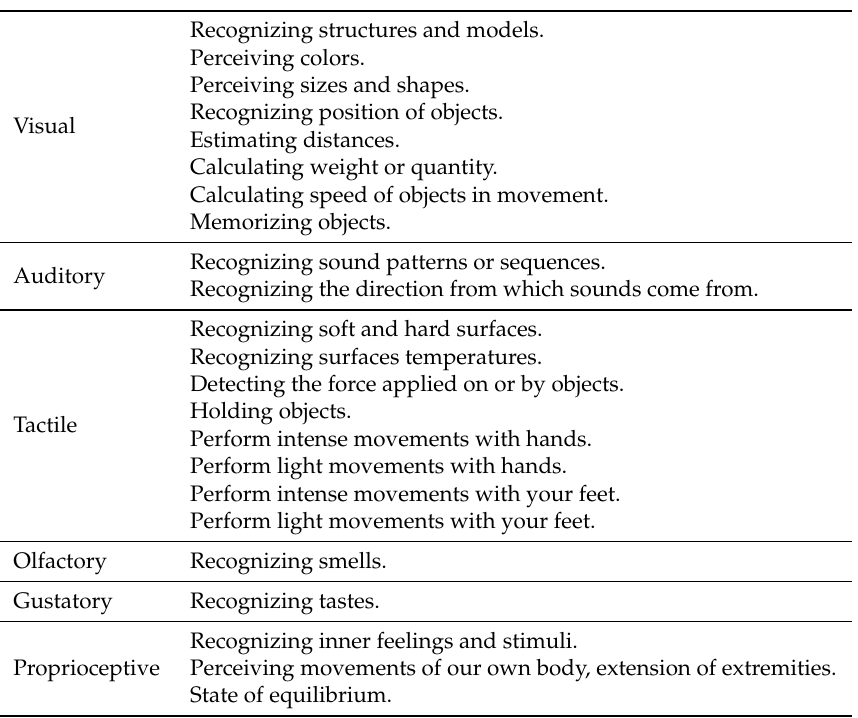
Table 1. The agent’s skills